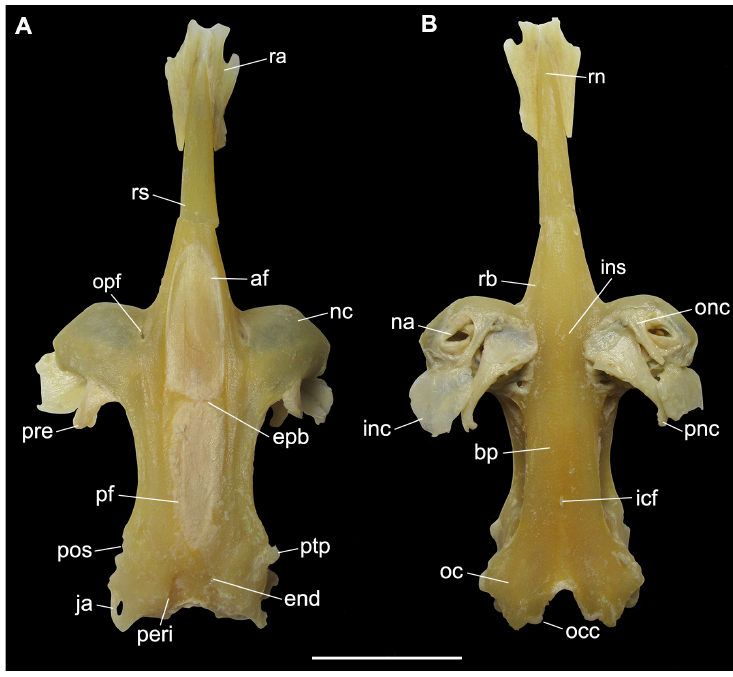
FIGURE 5 | Neurocranium of Rioraja agassizii , MZUSP 117280, female, 543 mm TL. A. dorsal, B. ventral views. af , anterior fontanelle; bp , basal plate; epb , epiphysial bridge; end , endolymphatic foramen; icf , internal carotid artery foramen; inc , inner nasal cartilage; ins , internasal space; ja , jugal arch; na , nasal aperture; nc , nasal capsule; oc , otic capsule; occ , occipital condyle; onc , outer nasal cartilage; opf , ophthalmic foramen; peri , perilymphatic foramen; pf , posterior fontanelle; pnc , posterior nasal cartilage; pos , postorbital process; pre , preorbital process; ptp , pterotic process; ra , rostral appendix; rb , rostral base; rn , rostral node; rs , rostrum. Scale bar = 10